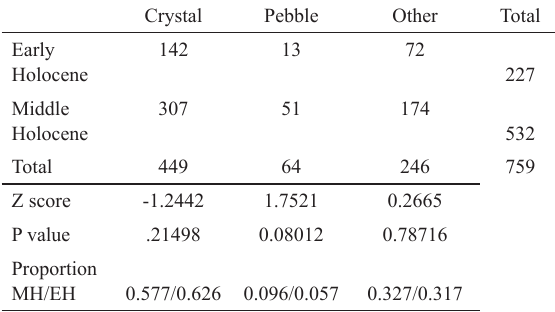
Number of elements and Z-test results (z score and p value) and proportion between Middle Holocene (MH) and Early Holocene (EH) types of